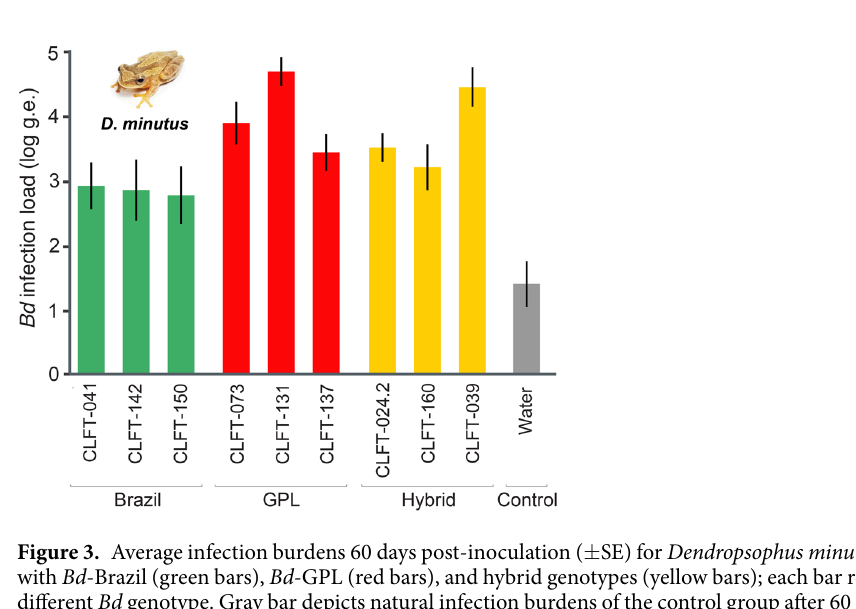
Figure 2. Average infection burdens ( ± SE) at the time of mortality for Brachycephalus ephippium and Ischnocnema parva inoculated with a hybrid genotype (yellow bars) and Bd -GPL (red bars).